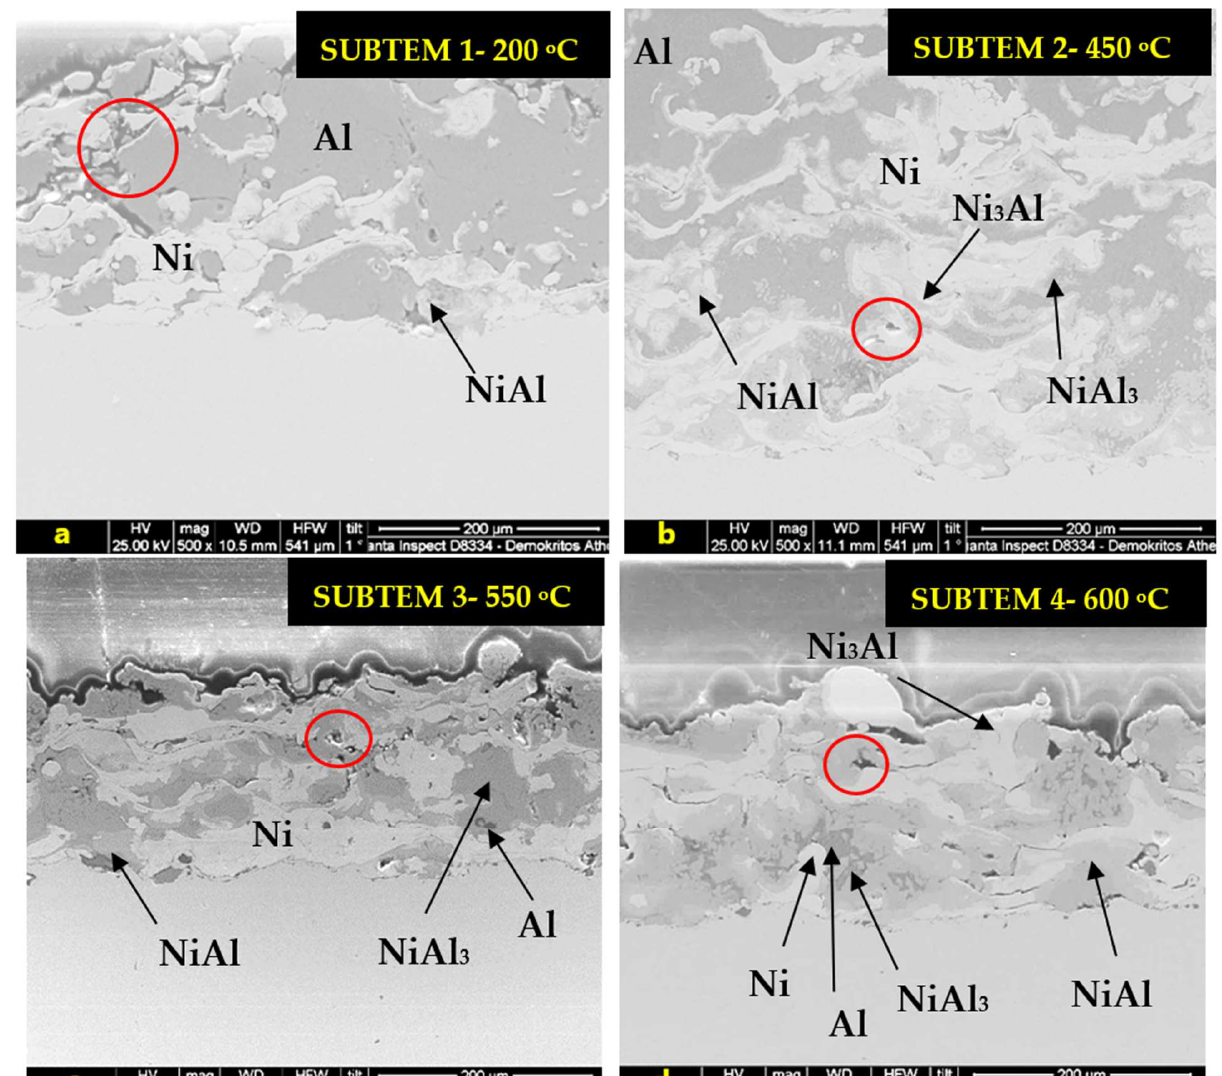
Figure 5. SEM (SE mode) micrographs of cross-sections of the coatings with various substrate temperatures: ( a ) 200 °C: SUBTEM 1, ( b ) 450 °C: SUBTEM 2, ( c ) 550 °C: SUBTEM 3 and ( d ) 600 °C: SUBTEM 4 and phase identification by EDX. Red circles enclose porosity of the coatings.